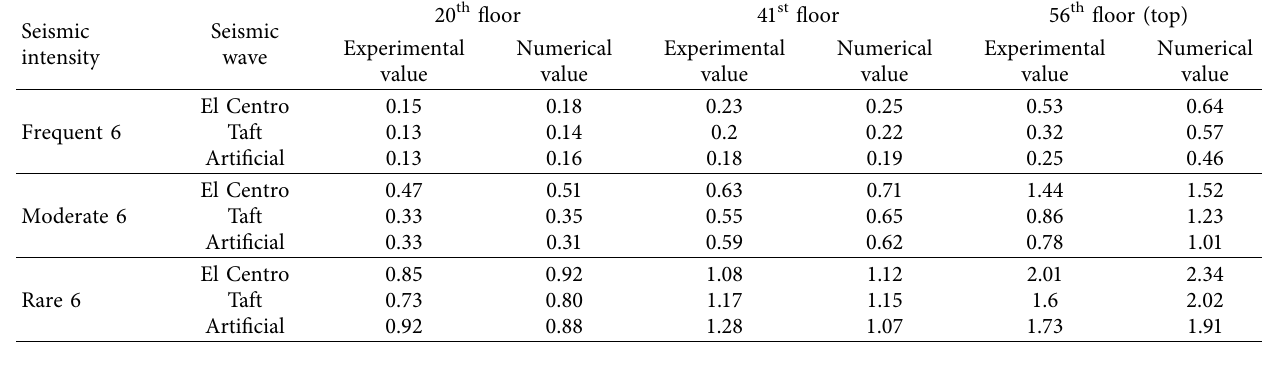
Table 13: Comparison of maximum displacements (cm).